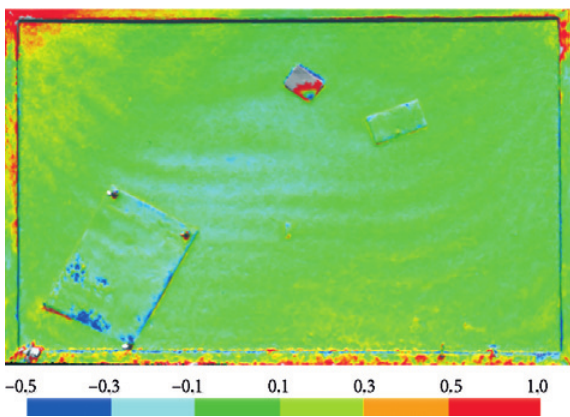
Fig. 5. A comparison of a 3D model made from a 30° line-of-sight tilt image set and the reference 3D model (differential scale in